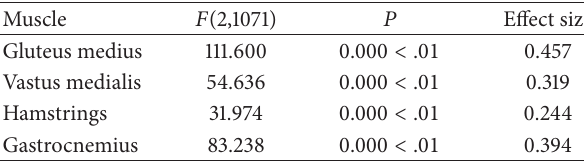
Table 1: Effect size of each muscle in slope